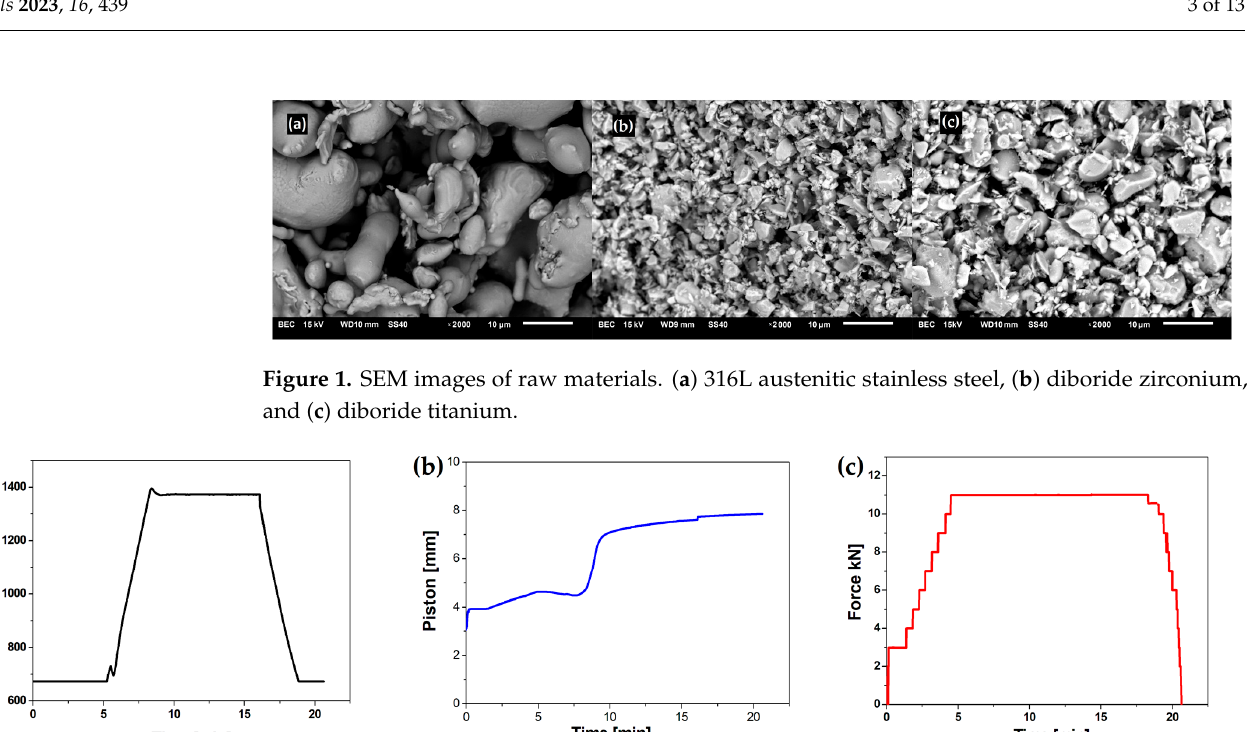
Figure 2. Actual ( a ) temperature–time, ( b ) displacement–time, and ( c ) pressure–time curves regis- tered during the SPS process. during the SPS